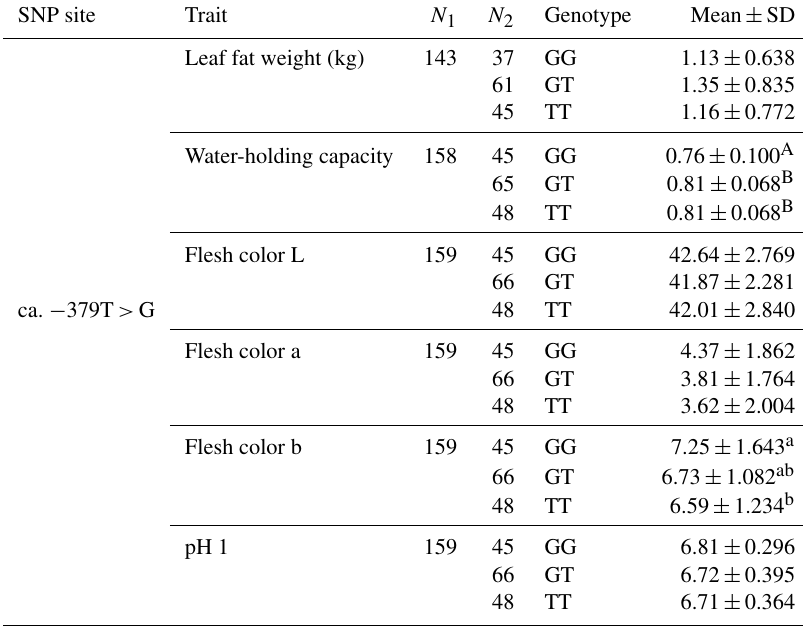
Table 3. Muscle traits of different genotypes at ca. − 379T > G in UBXN1 . SNP site